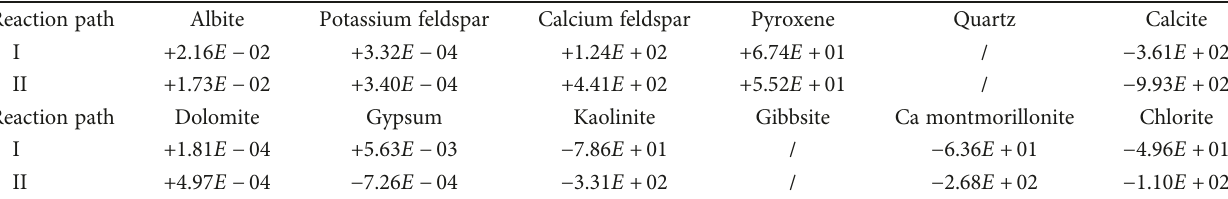
Table 6: The results of the hydrogeochemical simulation.